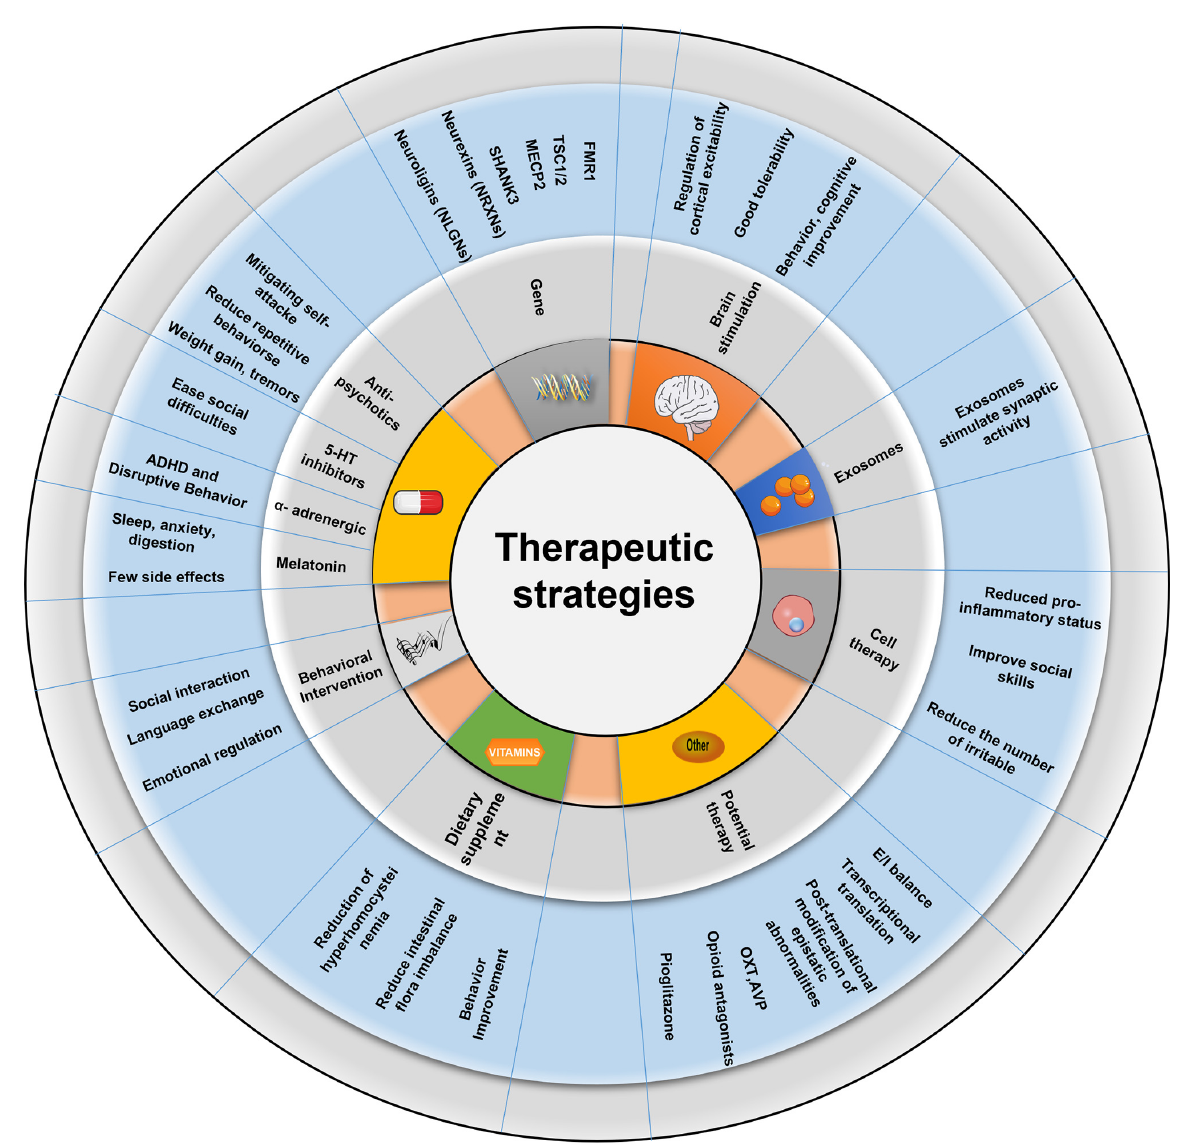
Figure 5. Potential therapy strategies for autism spectrum diseases. The small gray circles represent components of current ASD treatment strategies. Pharmacological treatments, nonpharmacological treatments, cellular and exosomal therapies, gene therapy, and potential emerging therapeutics are all covered. The large blue circles represent the benefits and drawbacks of various ASD therapy options for specific symptoms. Specific developments in emerging treatment methods are also dis- cussed.